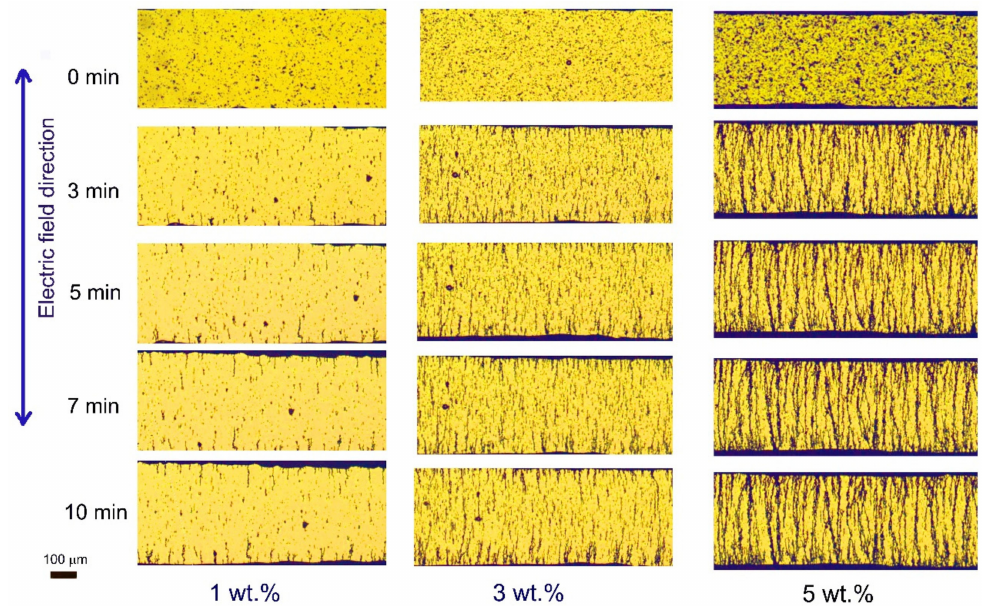
Figure 5. Effects of the concentration of the Ni@PS microspheres on the